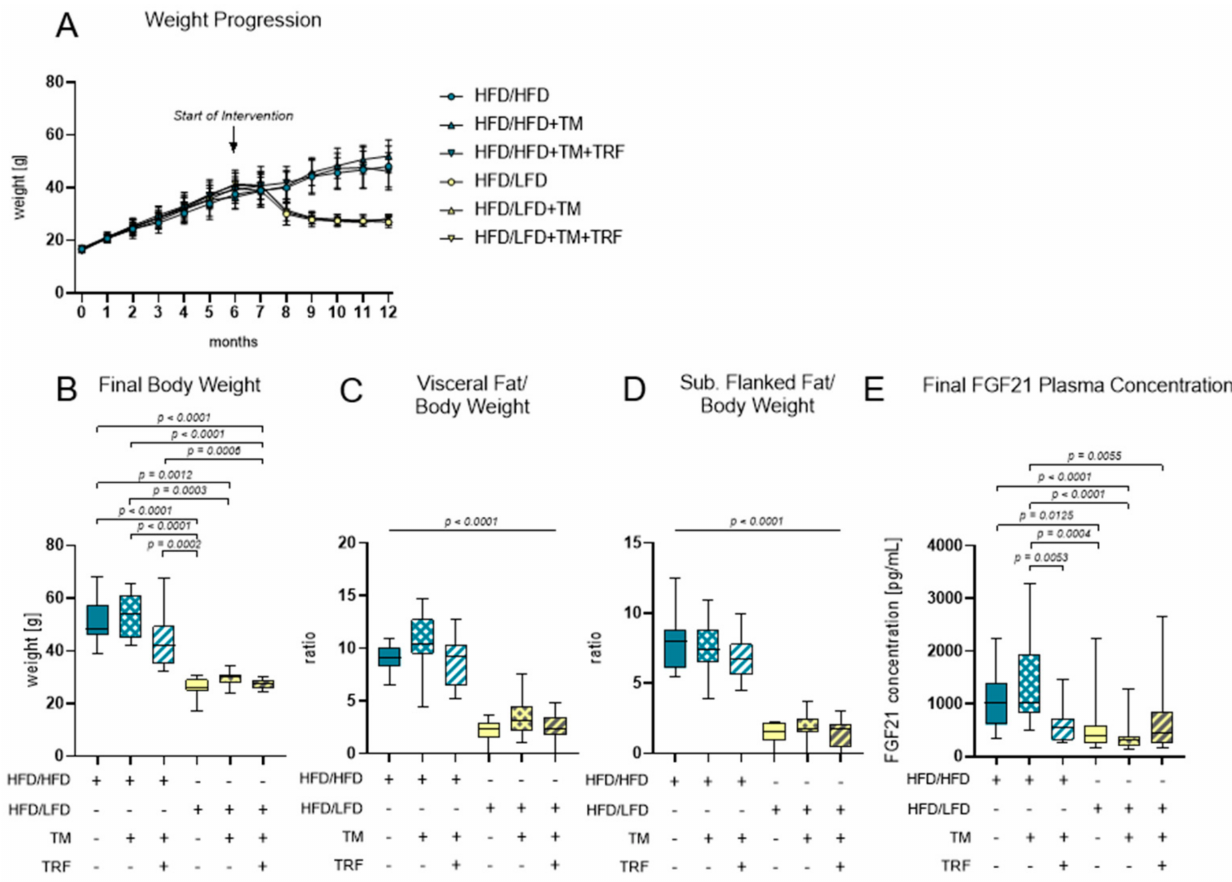
Figure 4. Body composition and FGF21 plasma concentrations. ( A ) Monthly weight progression with n = 90 mice at the beginning and n = 84 mice at final time point. ( B ) Final body weights [g] before euthanasia (HFD/HFD: n = 13, HFD/HFD + TM: n = 13, HFD/HFD + TM + TRF: n = 15, HFD/LFD: n = 13, HFD/LFD + TM: n = 15, HFD/LFD + TM + TRF: n = 13; total n = 82). ( C ) Ratio of visceral body fat deposits to body weight. ( D ) Ratio of subcutaneous flanked fat deposits to body weight. ( C , D ) All HFD/LFD groups showed a significant fat loss with p < 0.0001 when compared to all 3 HFD/HFD